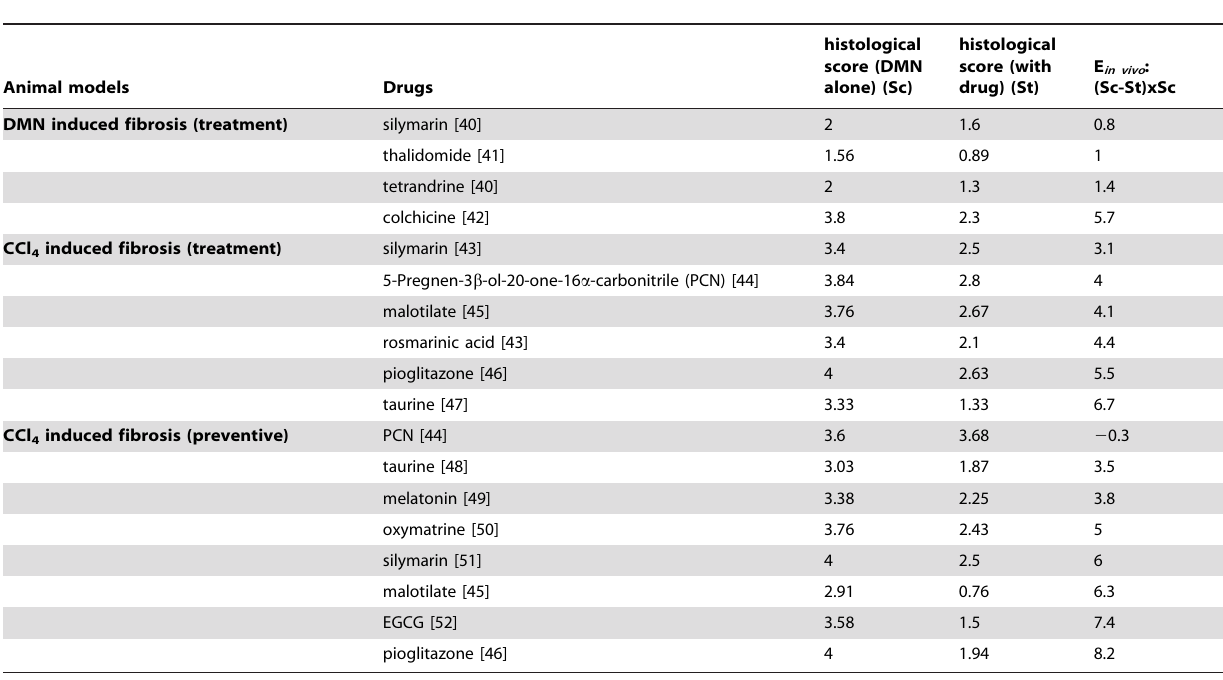
Table 1. Indexing of anti-fibrotic drugs from in vivo data.